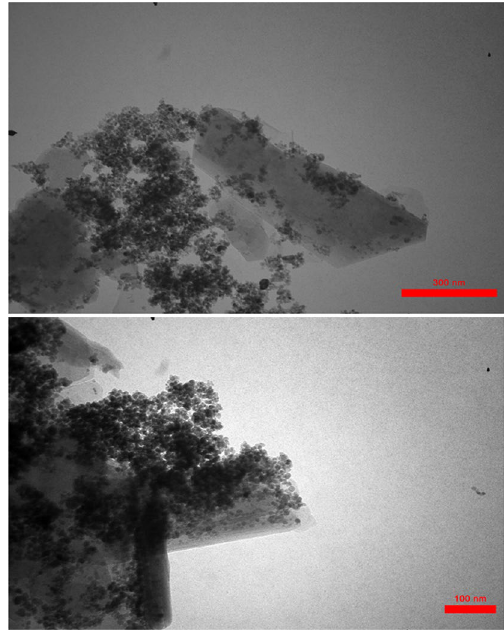
Figure 5. TEM images of HS-Alginate-Ag/Fe 3 O 4 .